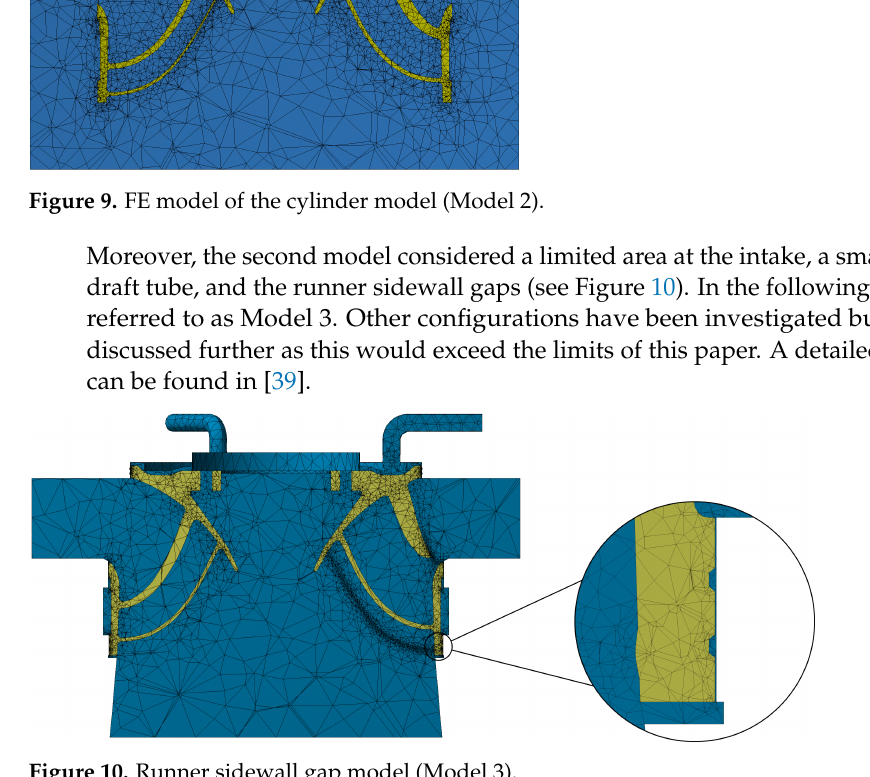
Figure 10. Runner sidewall gap model (Model